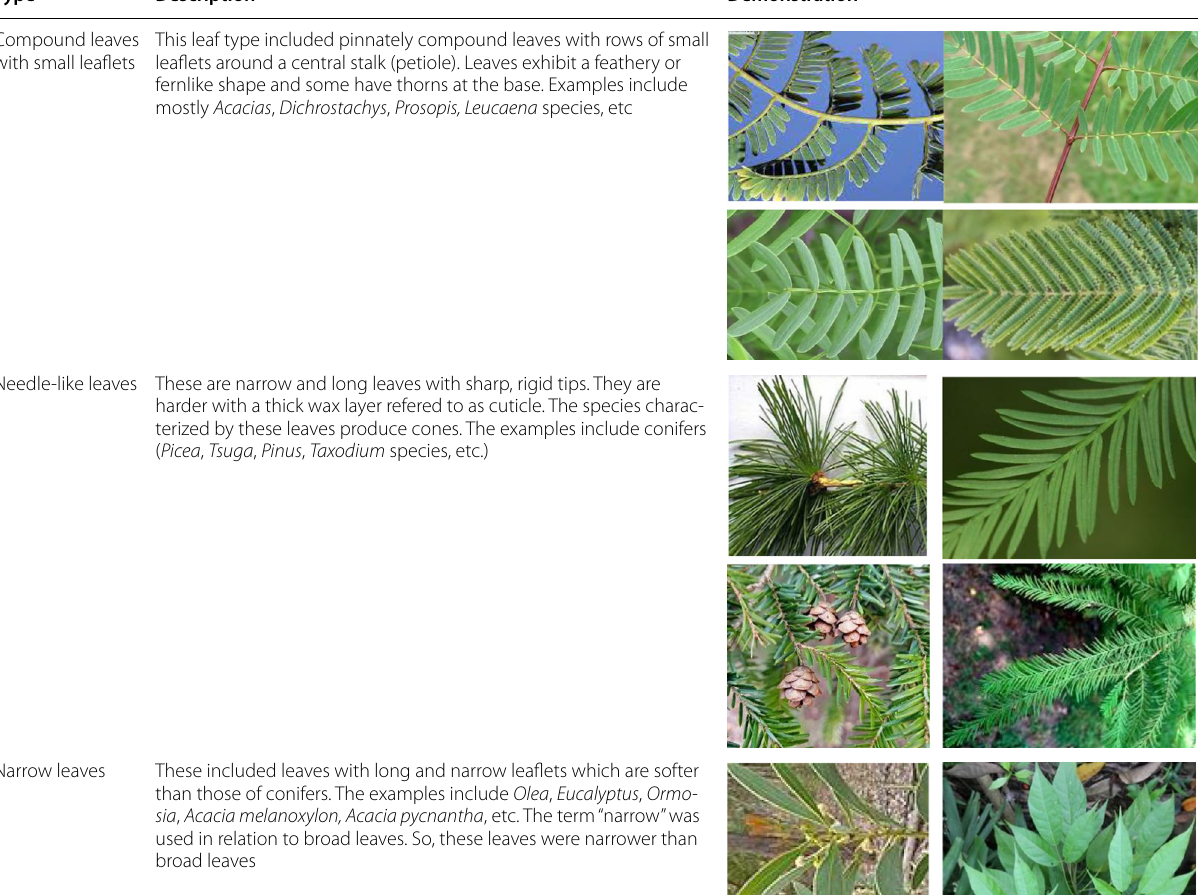
Table 1 The description and demonstration of leaf types of woody plants. Leaf images were adapted from www. google. com Type